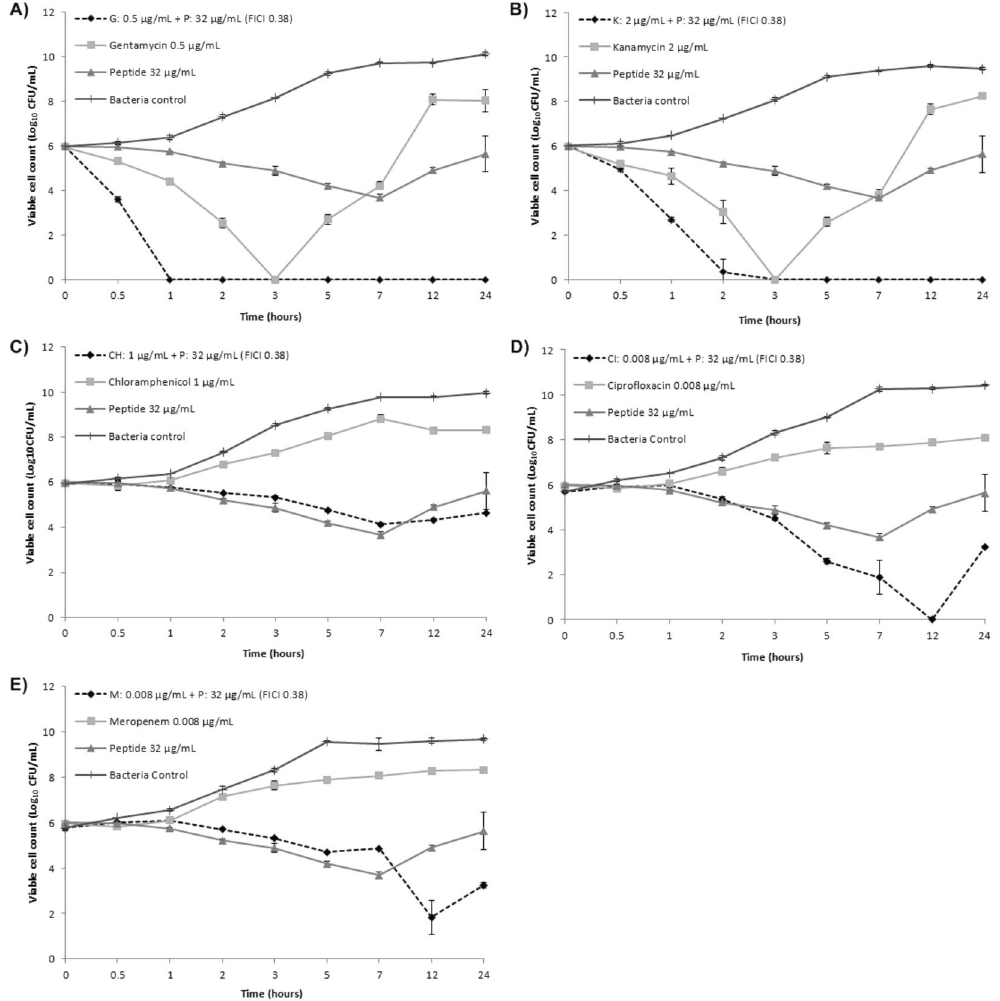
Figure 1. STEC survival over the course of a 24 hour killing assay as determined by serial plate count assay and expressed as viable counts per mL of culture. Each graph provides survival curves for STEC treatment with the subMIC concentrations of each of antibiotic or peptide or antibiotic-peptide combination relative to growth of untreated STEC (bacterial control). In all cases, the peptide dose was 32 µ g/mL and the FICI value for peptide- antibiotic combinations was 0.38. Time kill curves for peptide alone or in combination with ( A ) Gentamicin (0.5 µ g/mL) ( B ) Kanamycin (2.0 µ g/mL) ( C ) Chloramphenicol (1.0 µ g/mL) ( D ) Ciprofloxacin (0.008 µ g/mL) ( E ) Meropenem (0.008 µ g/mL). All assays were carried out in triplicate and on at least two different